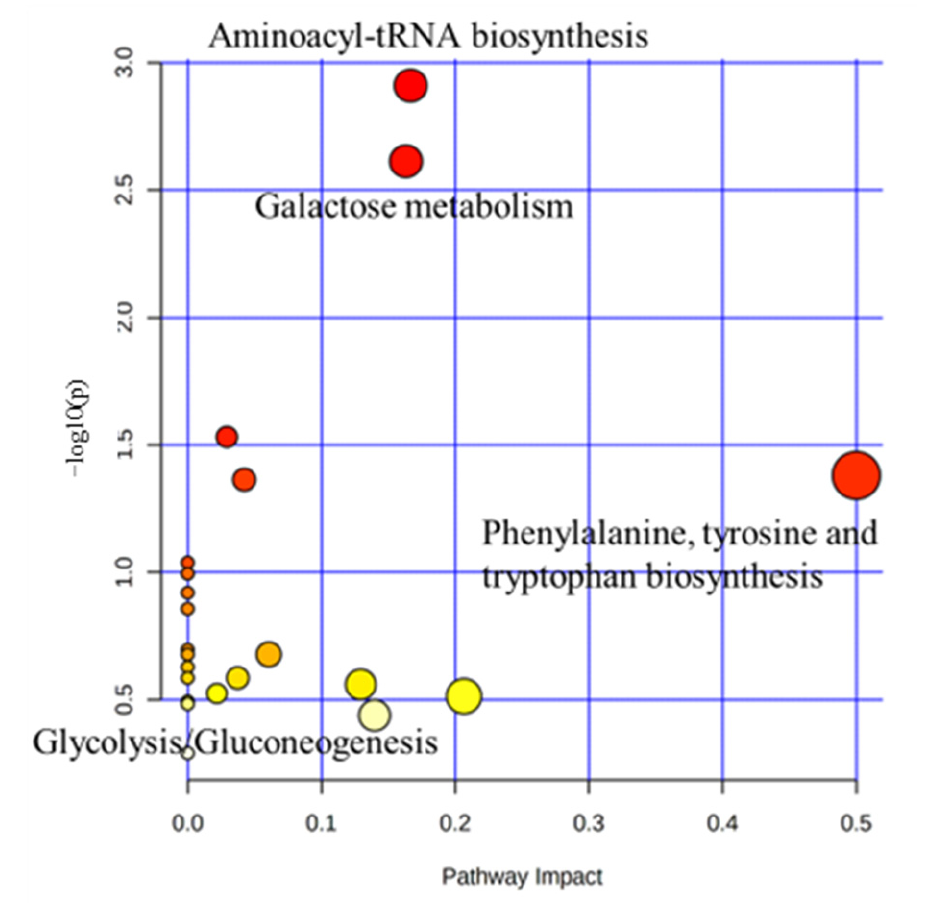
Figure 3. The metabolic pathway map related to metabolic profiling in serum, according to the effects of heat stress in each group. The x -axis represents the pathway impact values computed from pathway topological analysis, and the y -axis represents the − log of p -value obtained from pathway enrichment analysis. The pathways that were most significantly changed are characterized by both a high − log( p ) value and high impact value (top right region). The color and size of each dot were associated with the − log( p ) value and pathway impact value, respectively, where a small p value and high pathway impact value indicate the pathway is greatly influenced by heat stress.